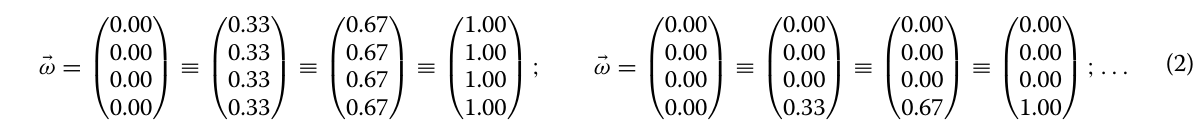
Table 1 Weight factor combinations leading to the best schedule for the 12 12 1 ω +